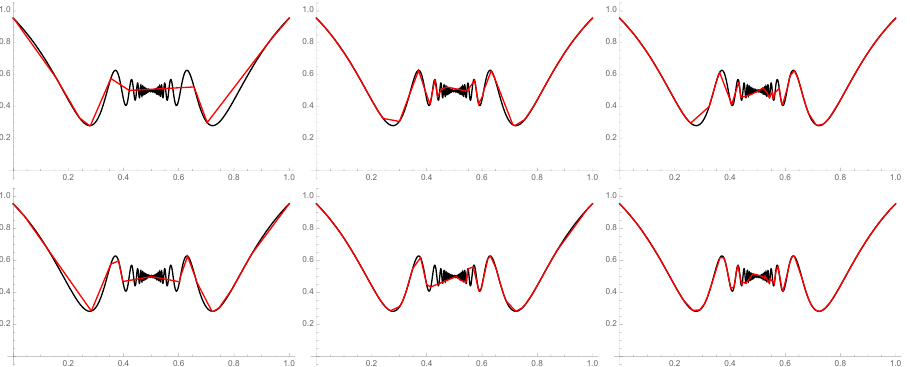
Figure 5. The graphs of the original function f 5 (the black lines) and its piecewise linearizations l f (the red lines), where (cid:96) = 12,40,100, I = 100, D = 80 (the first row) and (cid:96) = 25,60,100, I = 100, D = 1000 (the second